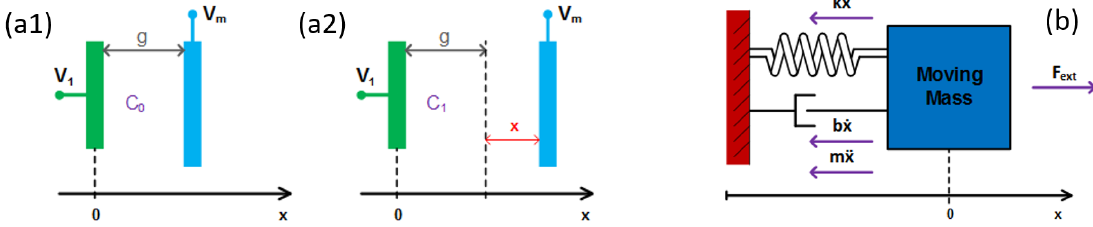
Figure 1. MEMS modeled as a variable single-ended parallel-plates capacitor: ( a1 ) at rest position; ( a2 ) at a displacement x with respect to rest position; and ( b ) lumped parameters model of a 1-DOF spring–mass–damper system with the balance of forces acting on the micro